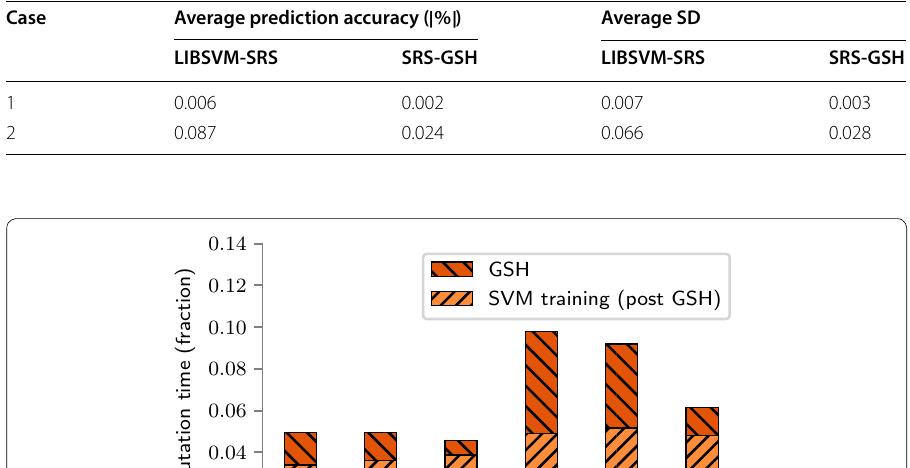
Table 9 Results on prediction accuracy